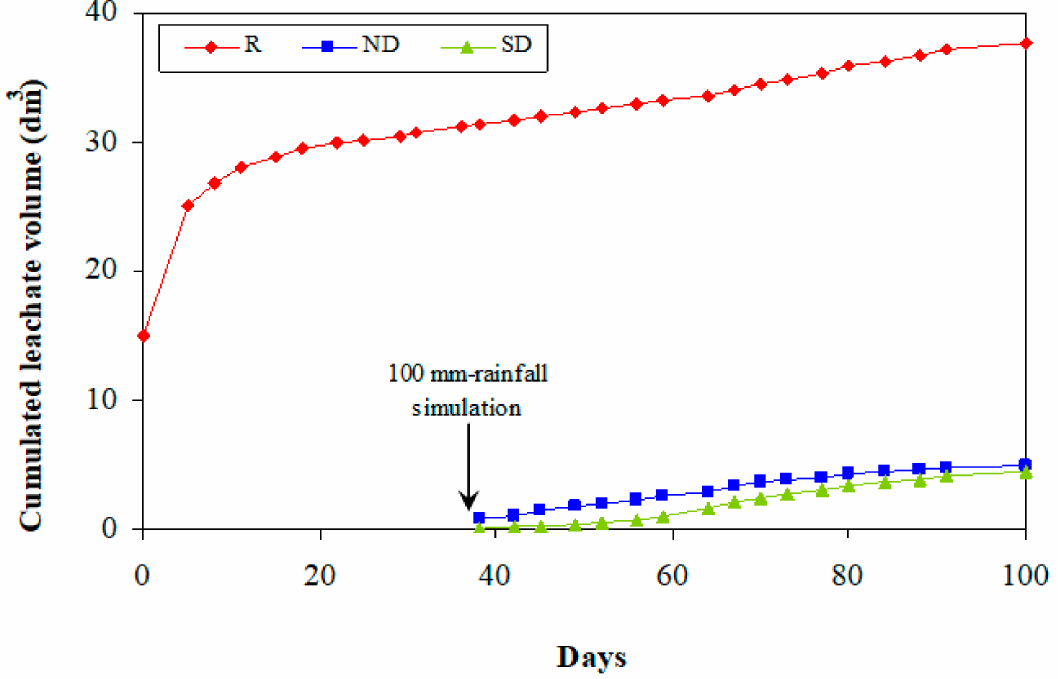
Figure 3. Temporal variation of leachate volumes in the lysimetric tests (R, raw OP; ND, naturally drained OP + rainfall; SD, solar-dried OP +